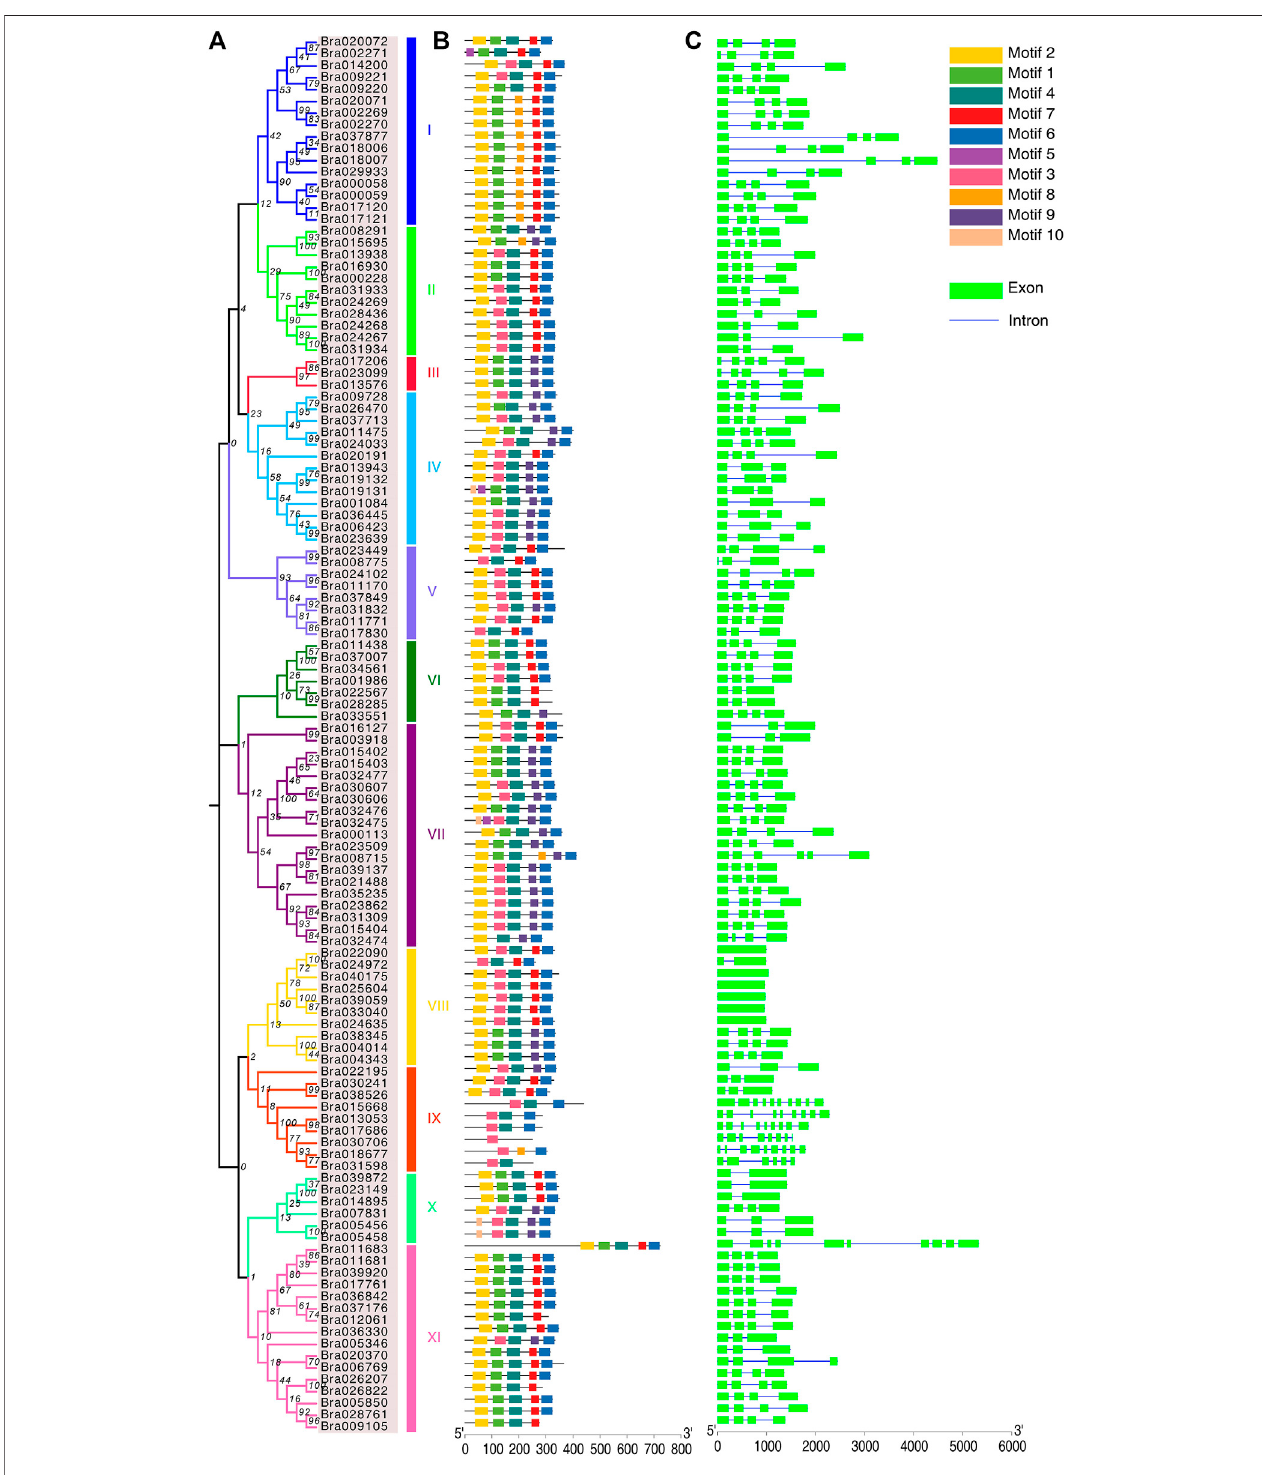
FIGURE 3 | Phylogenetic relationships, gene structure and motif analysis of BrAPXs. (A) Phylogenetic tree of BrAPXs; I to XI represent the 11 subgroups. (B) Distribution of conserved motifs in BrAPXs. Differently colored boxes represent the 10 conserved domains identi fi ed. (C) Gene structure of BrAPXs, where green boxes represent exons and blue lines represent introns. The lengths of the boxes and lines are scaled according to the length of the genes.